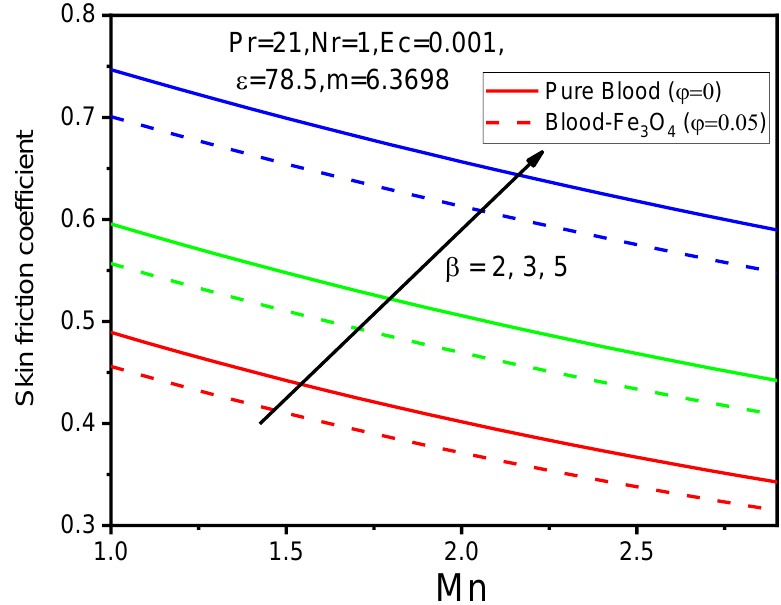
Figure 17. (Case a): Values of the skin friction coefficient for different values of β against Mn .